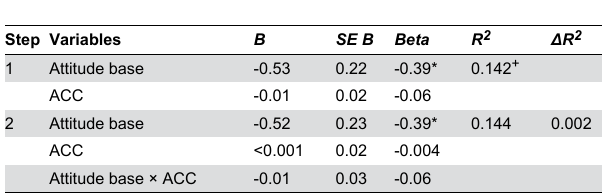
Table 1. Effects of attitude base and affective-cognitive consistency on attitude-behavior relation for intergroup consummatory behaviors in Study 1.